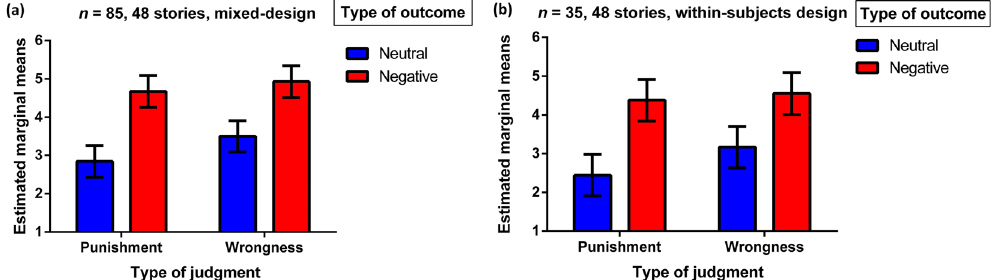
Figure 3. Increased reliance on outcomes for punishment versus wrongness judgments. The outcome-by- judgment interaction effect was observed in ( a ) a mixed-design and ( b ) a within-subjects design such that the difference in ratings for negative versus neutral outcomes was greater for punishment judgments as compared to wrongness judgments. Error bars represent 95% confidence